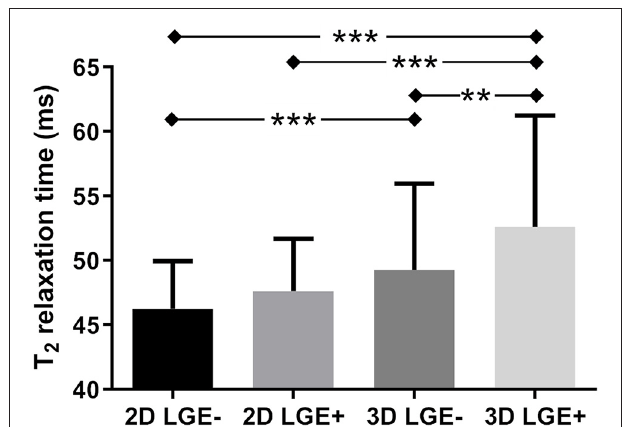
FIGURE 6 | T 2 relaxation times in myocardial segments with and without late gadolinium enhancement (LGE). The myocardium of the patients in the LGE images and T 2 maps was segmented according to the AHA guidelines, and all segments of all patients that were LGE-positive (LGE + ) were grouped, as were all LGE-negative (LGE–) segments. While there was no difference between the LGE– and LGE + segments as quantified with the routine 2D technique, a small but significant difference was detected with the proposed 3D T 2 mapping technique. **indicates p < 0.01, ***indicates p <